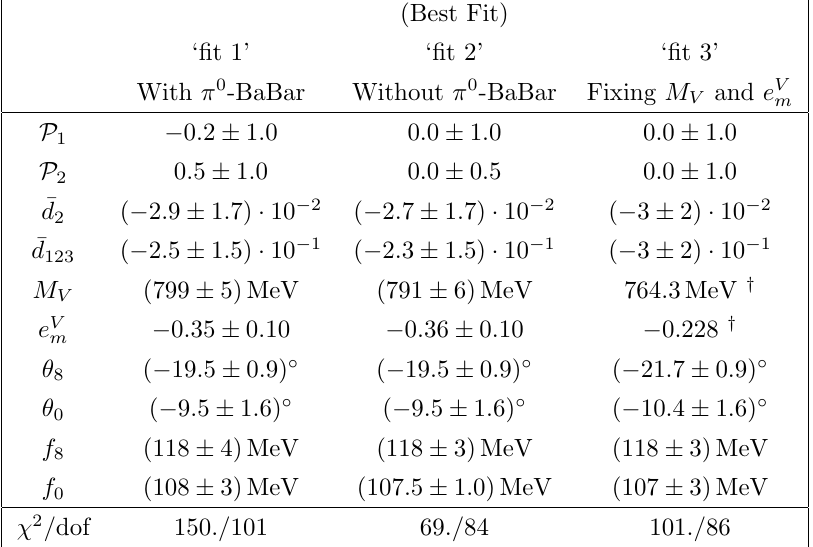
Table 7 . Values for the (cid:12)tted parameters with ((cid:12)rst column) and without (second column) BaBar data on the (cid:25) 0 form-factor. We (cid:12)t the parameters M V , e V and the mixing couplings together m with P 1 and P 2 , not (cid:22) d 2 and (cid:22) d 123 ; these are reconstructed from the (cid:12)tted values for P 1 and P 2 and eqs. (5.4a) and (5.4b) and shown here for illustration. The third column shows the parameters (cid:12)tted excluding BaBar (cid:25) 0 data and (cid:12)xing M V and e V (marked with y ) according to refs. [64, 65]. m The last row collects the (cid:31) 2 per degree of freedom (dof).